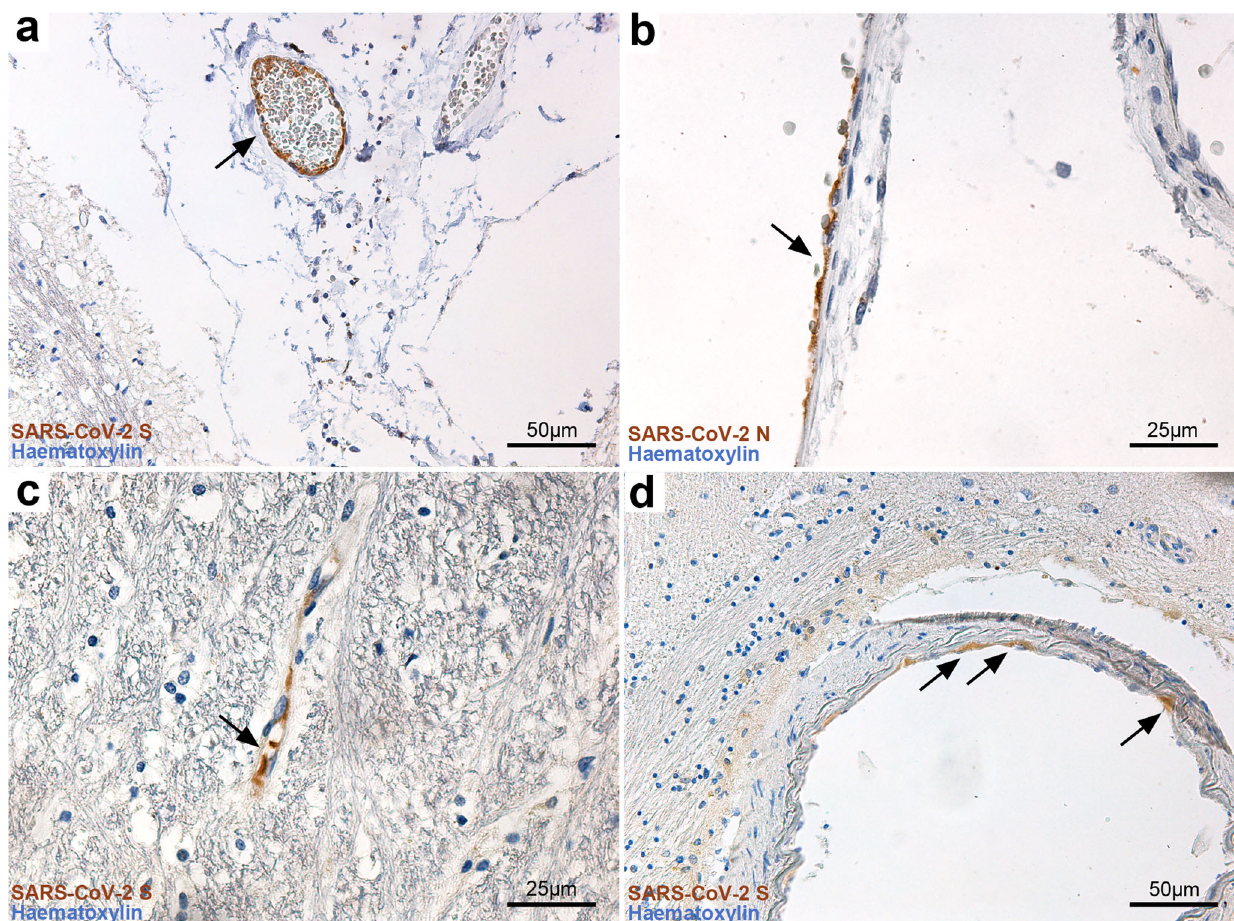
Fig. 4 Immunoperoxidase staining for SARS-CoV-2 viral proteins reveals endothelial cell immunoreactivity at the level of the brainstem. a SARS-CoV-2 spike protein immunohistochemistry revealing endothelial cell reactivity in a leptomeningeal vessel of the medulla oblongata. b SARS-CoV-2 nucleocapsid protein immunohistochemistry in a leptomeningeal vessel in the cerebellum. c , d SARS-CoV-2 spike protein immunohistochemistry revealing endothelial cell immunoreactivity in the CNS